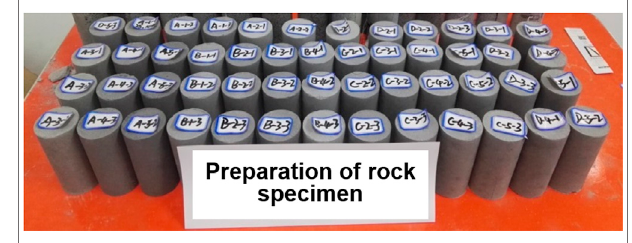
FIGURE 3 | Rock specimen preparation.